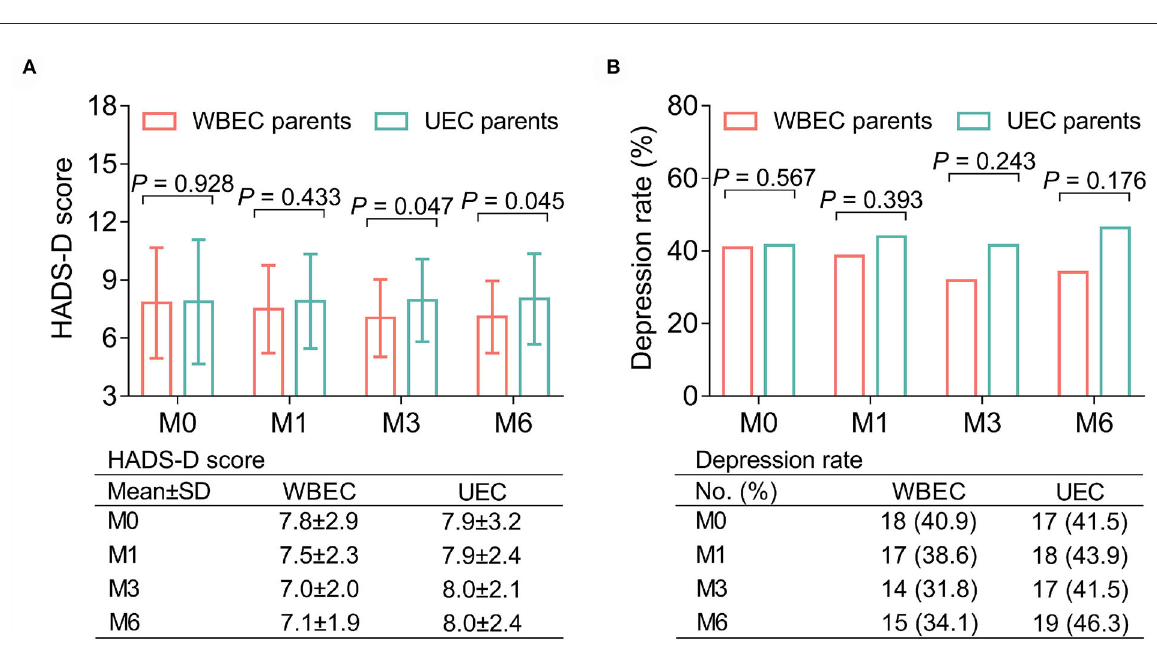
parents (Liu et al., 2021; Zhang et al., 2021, 2022).